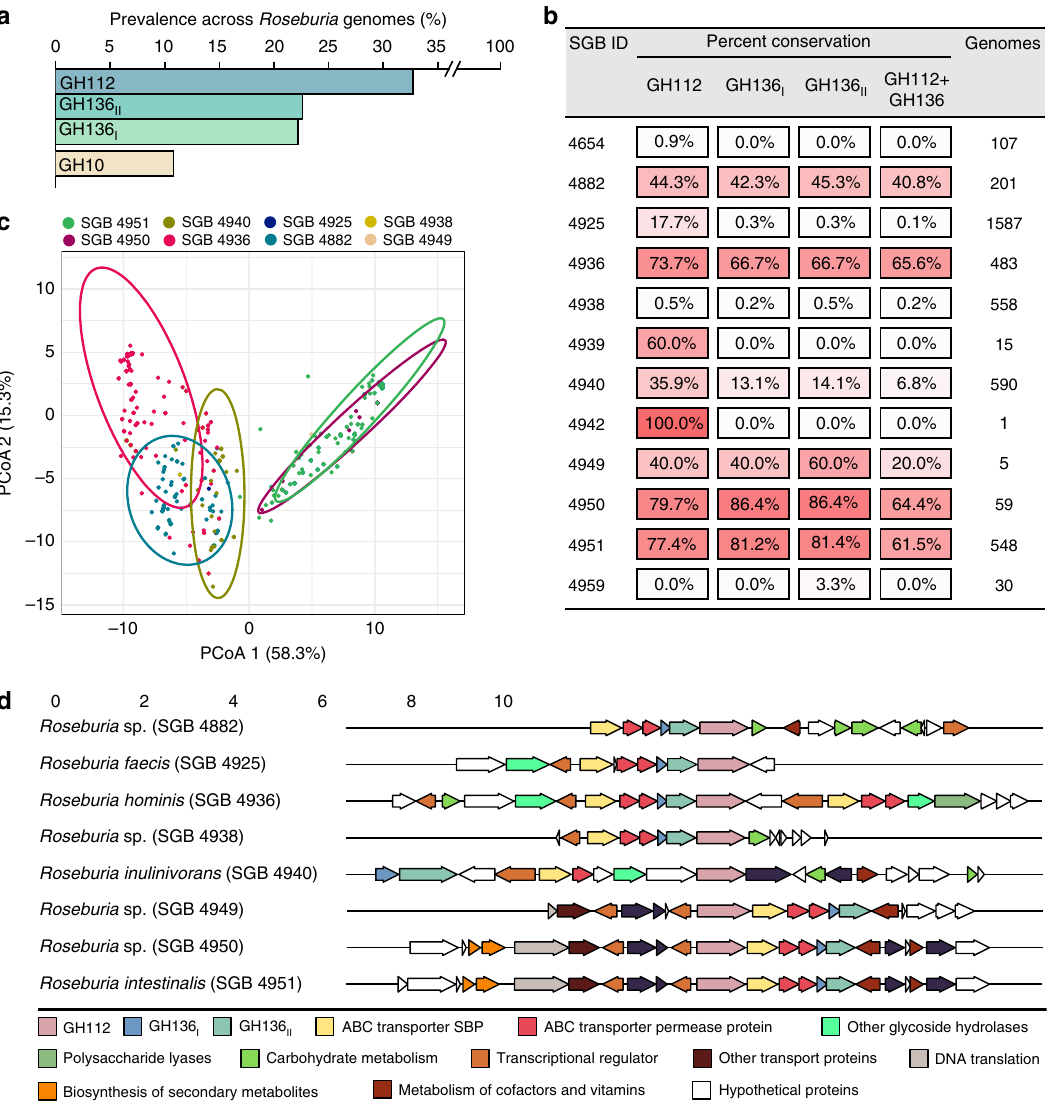
Fig. 5 The conservation and structure of HMO utilization loci in Roseburia . a Global abundance of GH112, GH136 I , GH136 II and GH10 xylanase genes in 4599 Roseburia genomes illustrating the broad occurrence and conservation of the HMO utilization apparatus. b Heat map showing the segregation of GH112-containing genomes from a into different species-level genome bins (SGBs) and the corresponding relative abundance patterns of HMO utilization genes within each SGB. This data shows the frequent co-occurrence of GH136 and GH112 genes, although some Roseburia strains encode only the GNB/ LNB degrading GH112. c Principal coordinate analysis of 818 Roseburia gene-landscapes de fi ned stringently based on ≥ 70% identity to the GH112 and GH136 with any of the fi ve references Roseburia genomes displayed in Supplementary Fig. 1 and including 10 proteins up- and downstream of the GH112. d The most frequently occurring gene landscapes in each Roseburia SGB, as anchored by aligning at the 3 ′ terminal of GH112 genes. The gene landscape analyses provide a signature for the HMO utilization loci that are de fi ned by at least one GH112, a GH136, an ABC-transporter, and a